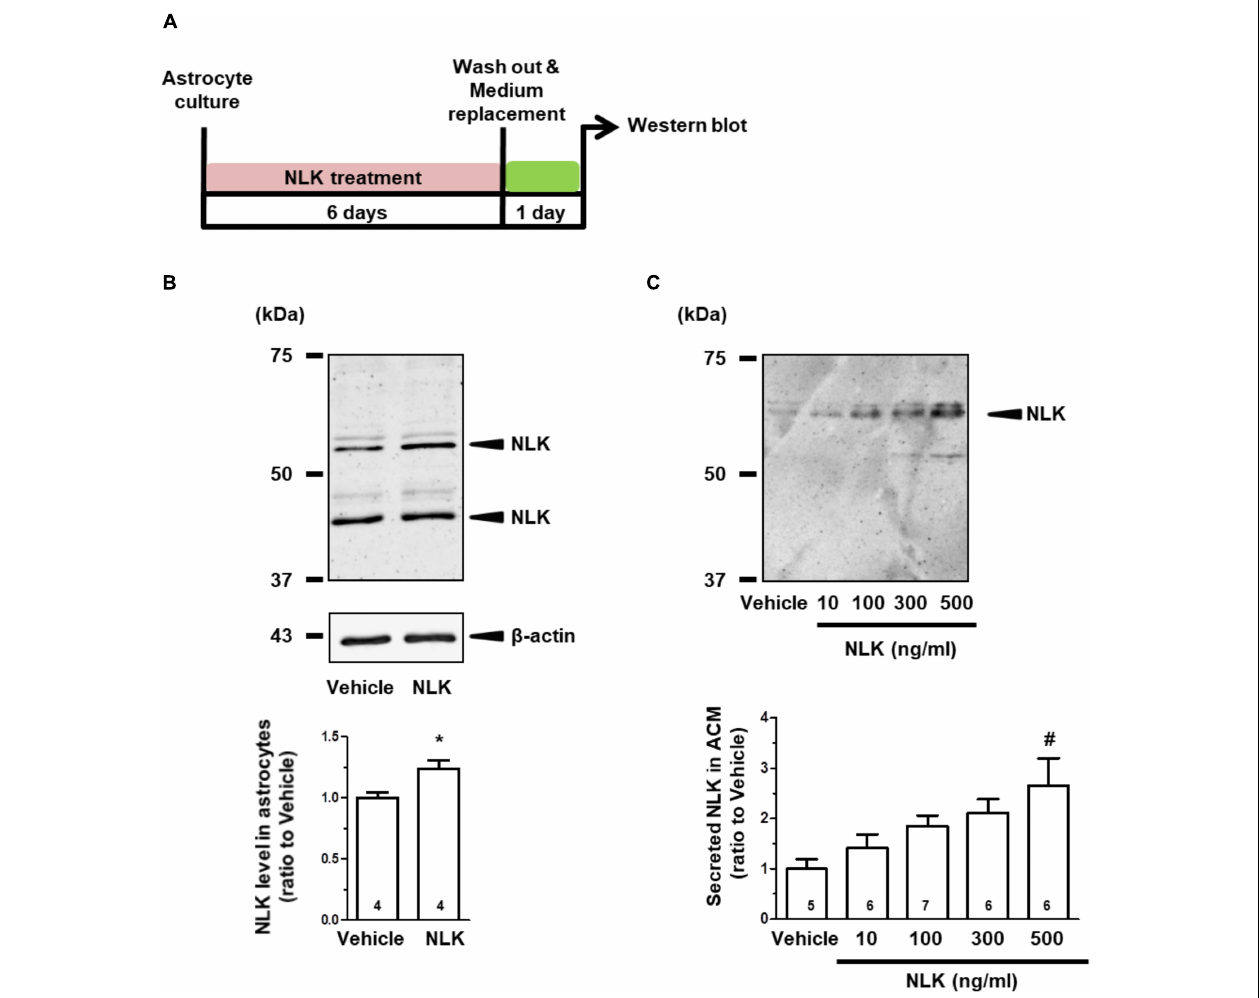
FIGURE 1 | Neuroleukin (NLK) treatment enhances NLK secretion from cultured astrocytes. (A) Spinal cord astrocytes were cultured for 4 h and then treated with recombinant NLK (10, 100, 300, or 500 ng/ml) or vehicle for 6 days. The medium was replaced with supplement-free medium and 24 h later the medium was collected as astrocyte conditioned medium (ACM). (B) NLK in the lysates of cultured astrocytes was detected by western blotting. Band intensities of NLK in the lysates were quantified. ∗ p < 0.05 vs. vehicle, unpaired two-tailed t -test. The numbers in the graph bars indicate the number of experiments. (C) NLK in ACM was detected by western blotting. Band intensities of NLK in ACM were analysed. # p < 0.05 vs. vehicle, one-way ANOVA post hoc Bonferroni test. Numbers in the graph bars indicate the number of experiments.